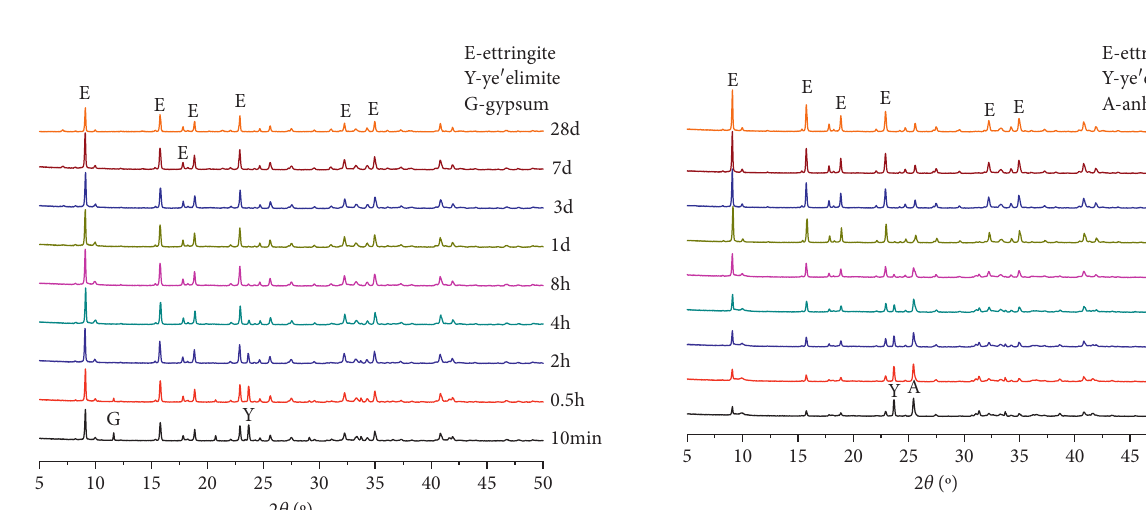
Figure 4: X-ray diffraction analysis of CSA-A under different hydration ages.